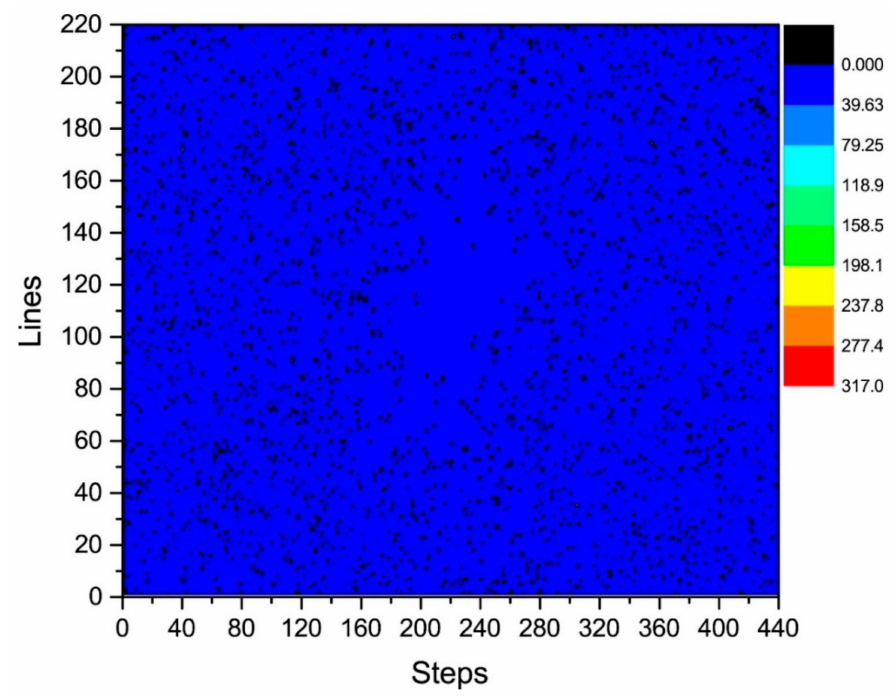
Figure 8. Statistical graph of phase difference (error) distribution in the plane between K τ − 6 and K τ − 12